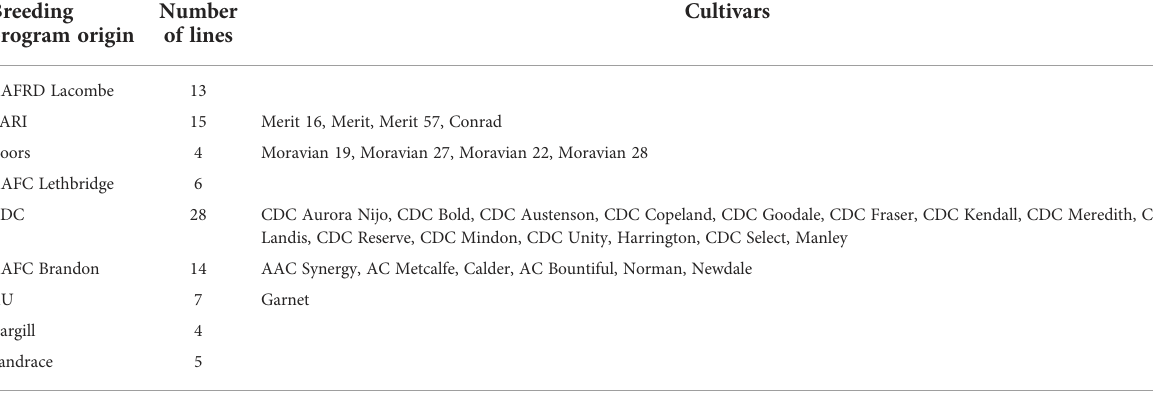
TABLE 1 The breeding program origin for barley lines in the current study. Breeding Number program origin of lines